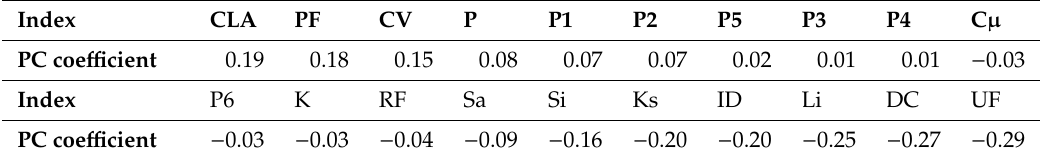
Table 6. PC coe ffi cient (principal component analysis) of each